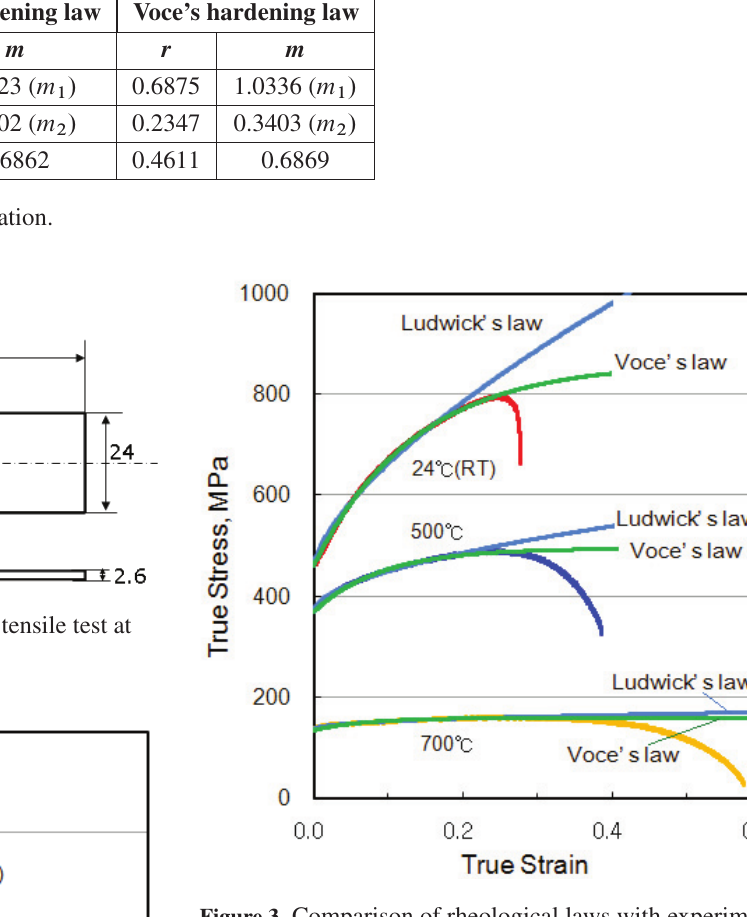
Figure 3. Comparison of rheological laws with experimen- tal data at room and elevated